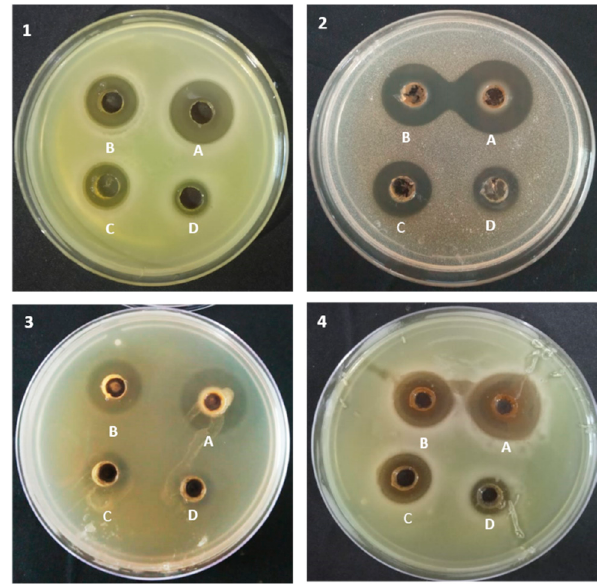
Figure 4. Antagonistic activity of anthocyanin extracts of black wheat flour against. ( 1 ) Staphylococcus aureus , ( 2 ) Pseudomonas aeruginosa , ( 3 ) Escherichia coli , and ( 4 ) Candida albicans at different anthocyanin extract concentrations; A = 200 mg/mL; B = 150 mg/mL; C = 100 mg/mL; D = 50 mg/mL. Table 2. Zones of inhibition (cm) in the growth of human pathogens by anthocyanin extracts from colored wheat flour and wheat-grass juice. Wheat Extract Sample Conc.